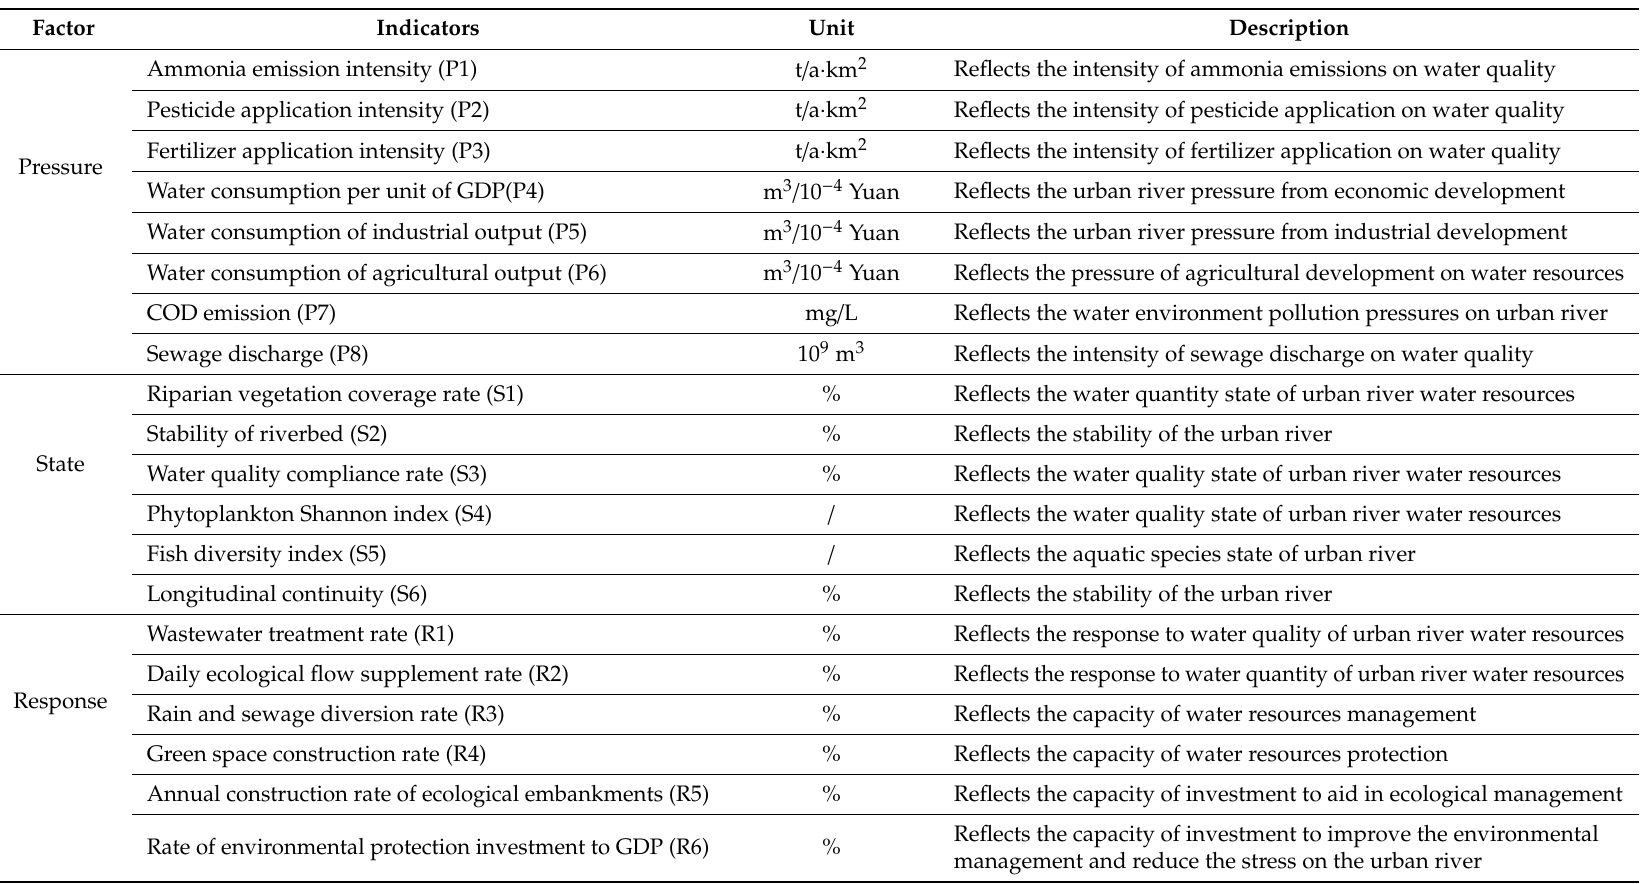
Table 1. Urban river health evaluation index